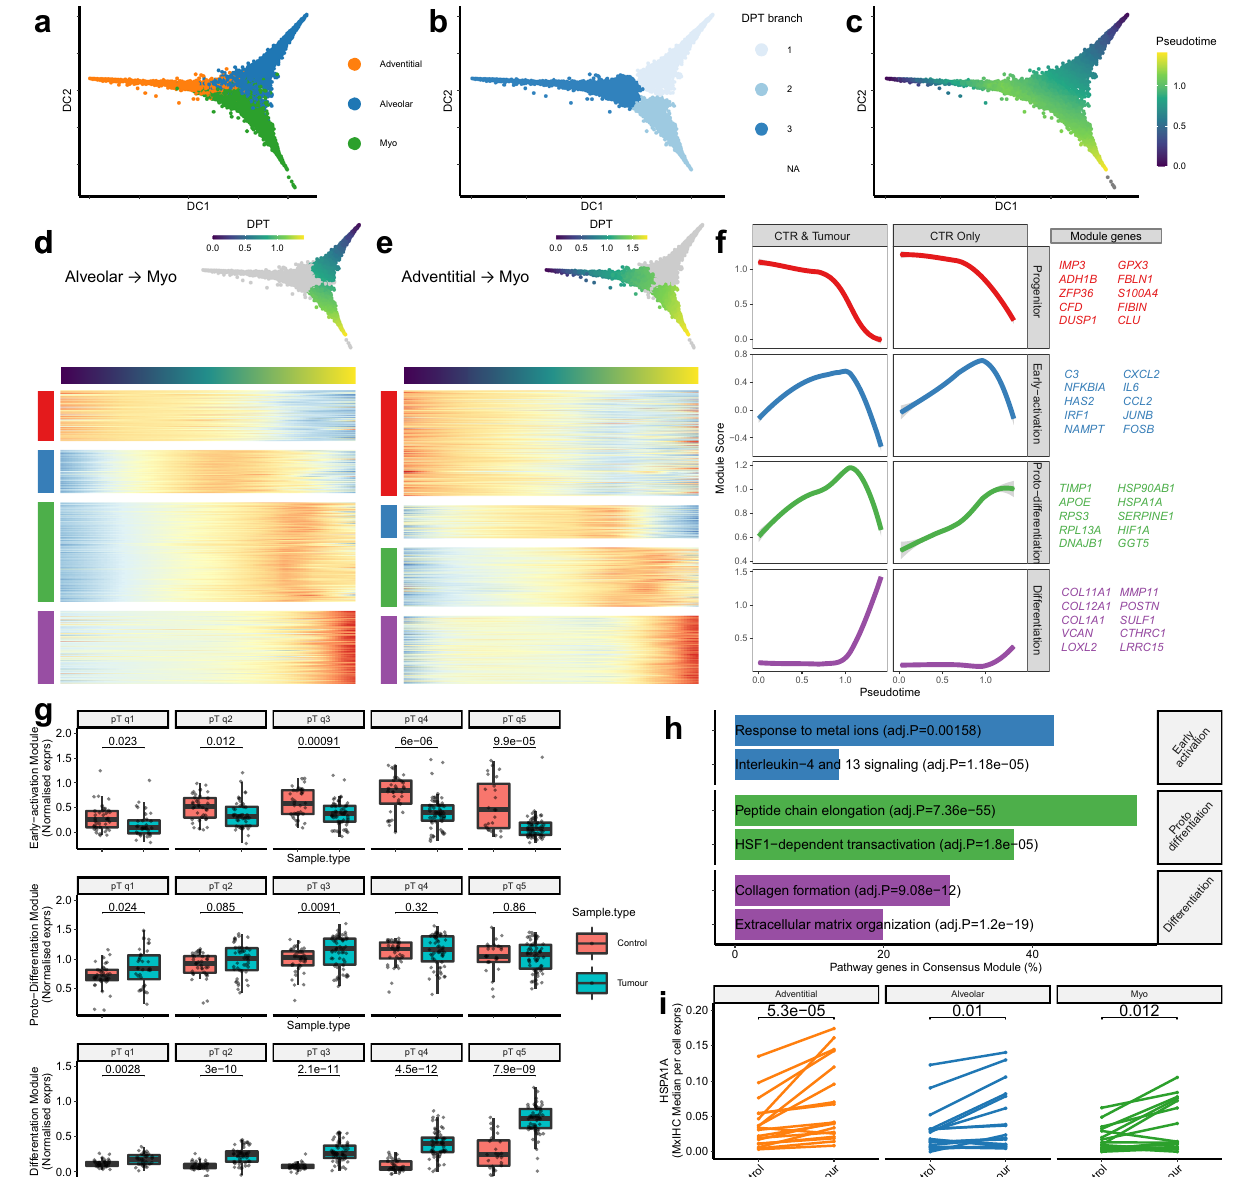
Fig.4|Trajectoryinferenceidenti fi esconsensusgenemodulesassociatedwith the transdifferentiation from alveolar or adventitial fi broblasts to myo fi bro- blasts. a 2D visualisation (diffusion map dimensionality reduction) of the inte- grated fi broblast scRNA-seq dataset, highlighting the three subpopulations. b As per a , highlighting cells assigned to each diffusion pseudotime (DPT) branch. c As per a , showing the relative position of each cell in DPT. d Heatmap showing genes differentially expressed as alveolar fi broblasts progress to myo fi broblasts in DPT. Hierarchicalclustering wasused to group thesegenesinto modulesde fi ned bythe DPT expression pro fi le. Complete differential expression results are provided in Supplementary Data 12. e As per d , genes differentially expressed as adventitial fi broblastsprogresstomyo fi broblasts.Completedifferentialexpressionresultsare provided in Supplementary Data 12. f Loss curve plots showing the expression pro fi les for each consensus DPT module in datasets consisting of control and tumour samples oronly controltissue samples. Consensus modules consist of genes assigned to the same cluster in both alveolar to myo and adventitial to myo